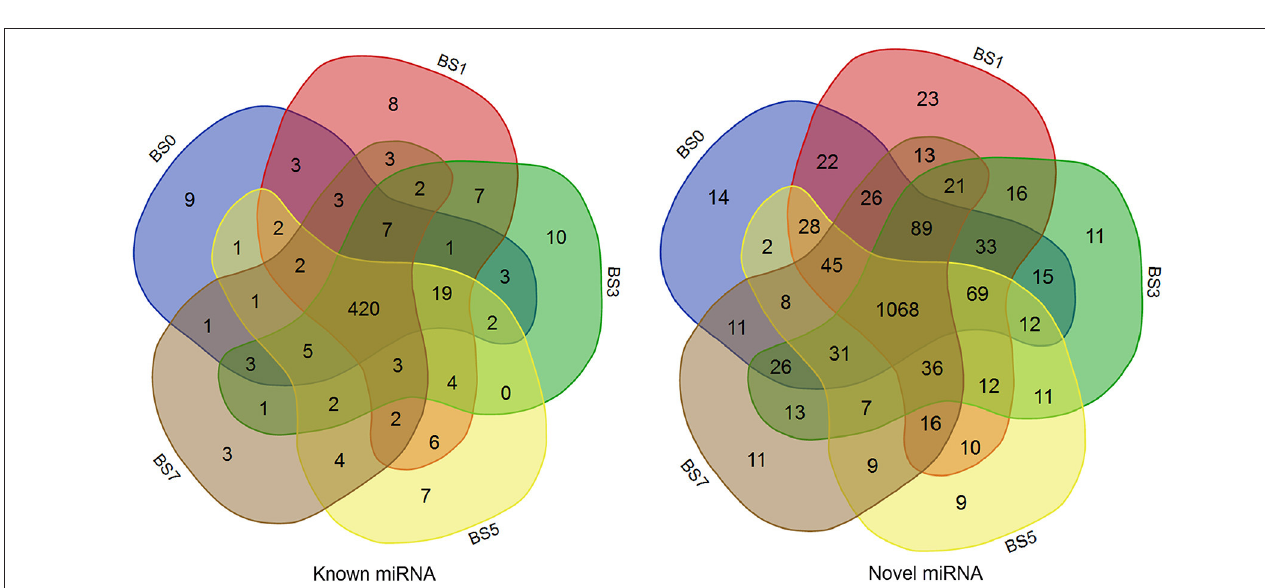
FIGURE 2 | Comparison of miRNA expression in peripheral blood of dairy cows at different times of post-induction (Venn diagram). BS0, BS1, BS3, BS5, and BS7 in the figure represent the groups at 0, 1, 3, 5, and 7 days after S.aureus induction.